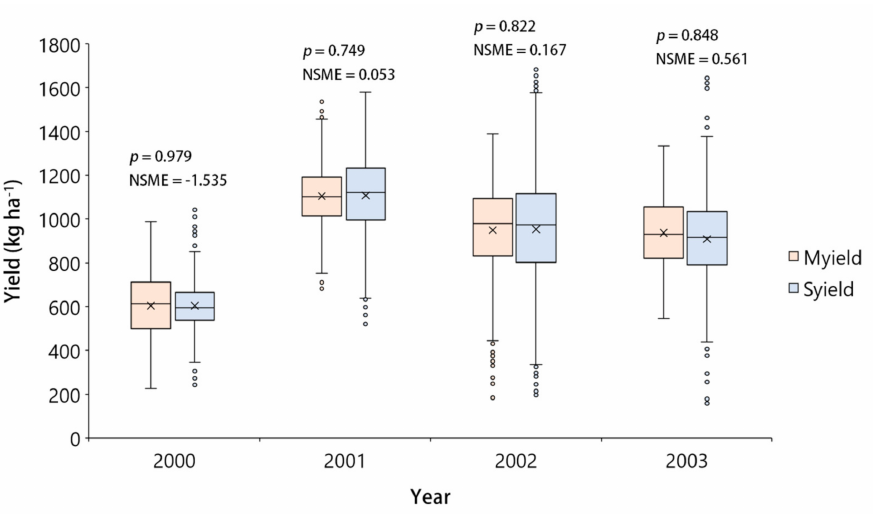
Figure 9. Box and whisker plots comparing p values according to the t -test ( α = 0.05) and Nash– Sutcliffe model efficiency (NSME) values for the simulated (S) and measured (M) cotton lint yields of field #30 over time. Error bars and boxes represent the 10th, 25th, 75th, and 90th percentiles of the yield data, showing the median (solid line) and mean ( × ), where circles indicate